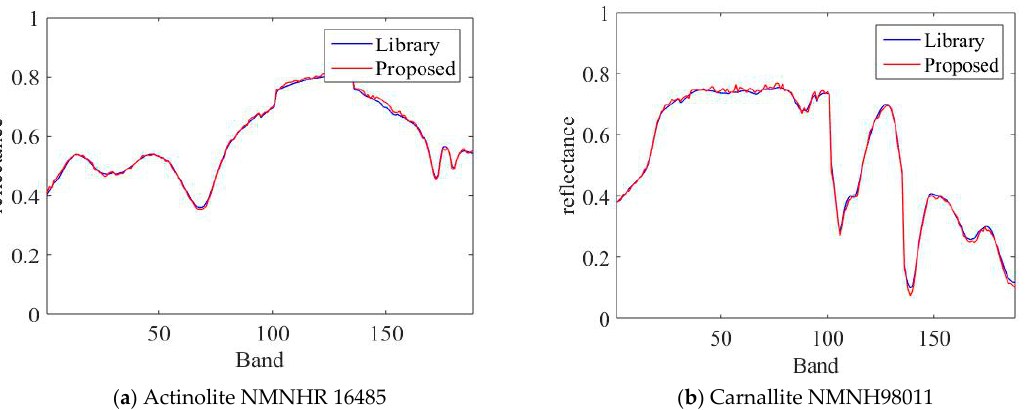
Figure 1. Comparison of the two end-members spectra obtained using NMF estimation in the simulated data with the real end-members spectra.